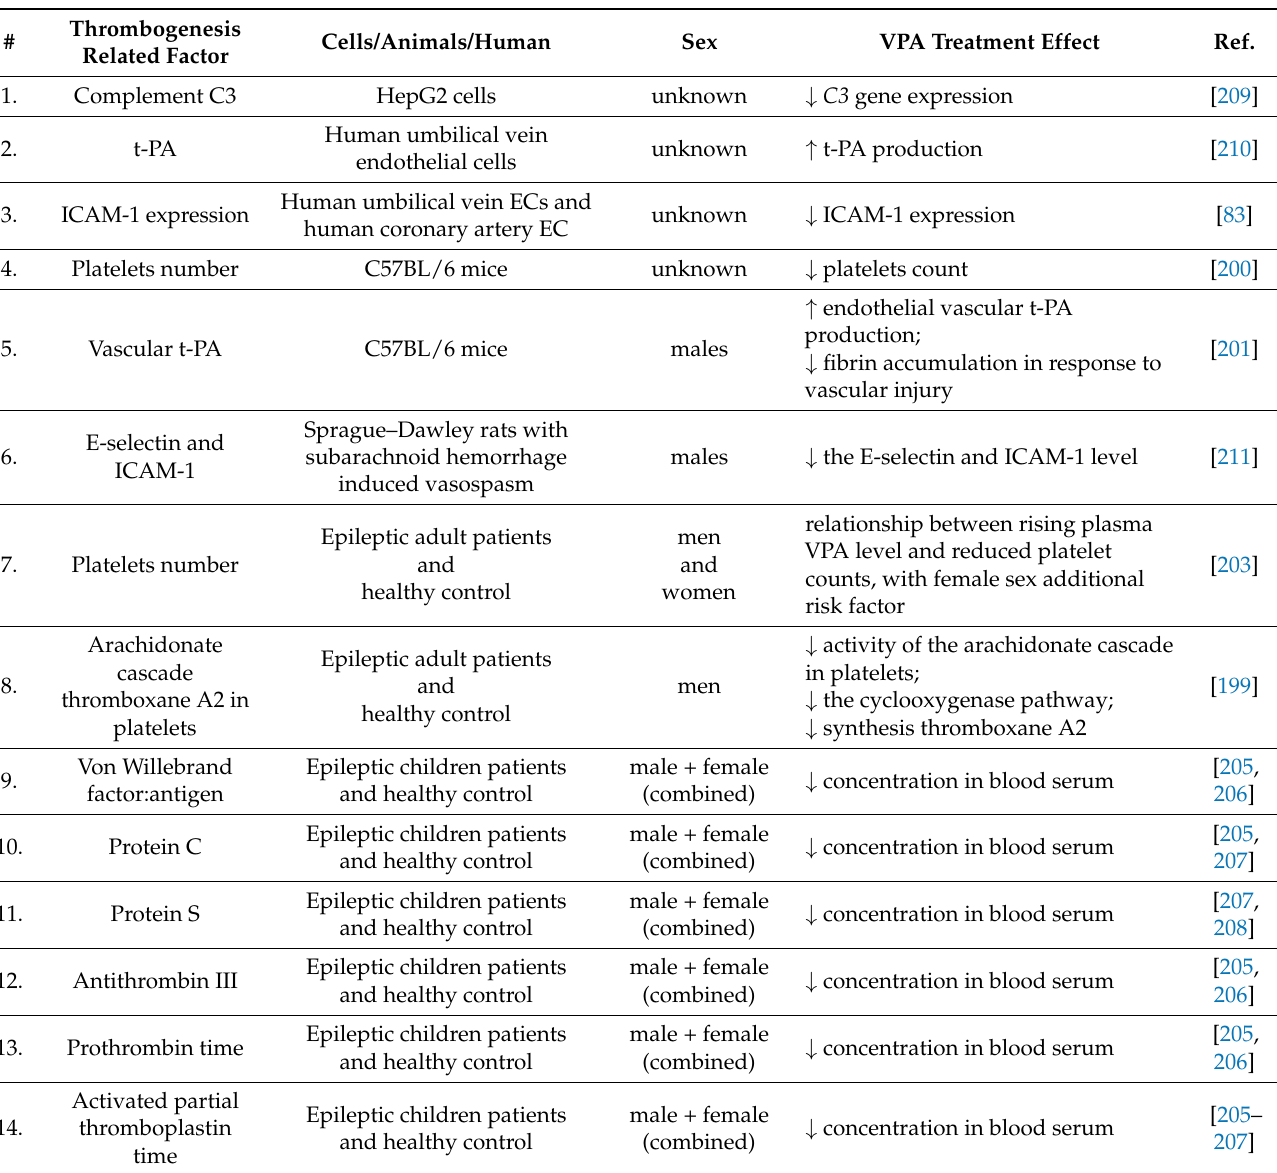
Table 2. VPA treatment effect on